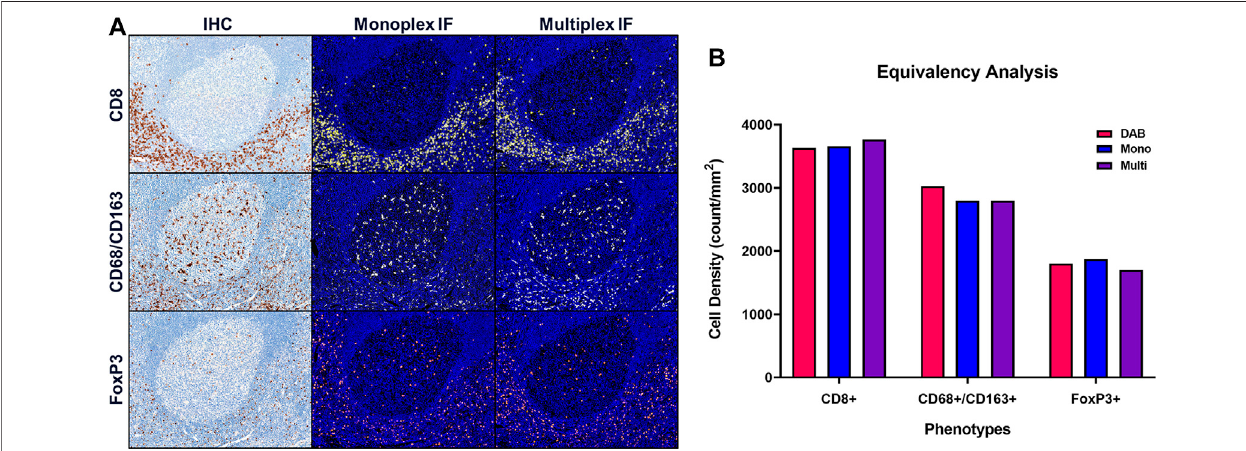
FIGURE 6 | Quantitative assessment of equivalence to chromogenic IHC staining. Staining parameters for each antibody are fi rst optimized using single stain, chromogenicIHContonsilsections.Next,eachprimaryantibodywaspairedtoaselectTSA fl uorophoreandasingle-stain,monoplexIF(monoIF)wasperformed.Lastly, all ofthemonoplex conditionsarecombined intoamultiplexIF (mIF)panel. (A) Representativeimage showing serial sections witheach marker forIHC, monoIF, andmIF staining. (B) Quantitative assessment of each image demonstrating the equivalence of staining for each marker across the three staining parameters, wherein monoIF and mIF are consistent with